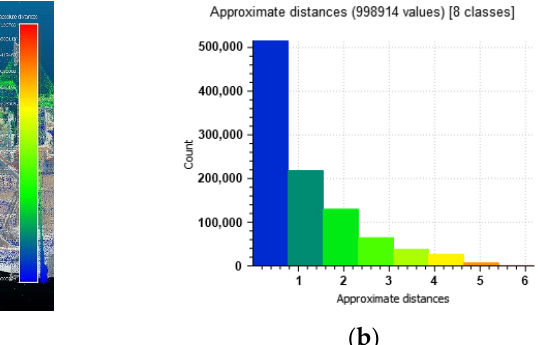
Figure 11. The Kunerad Castle model connected with terrestrial and aerial photogrammetry.